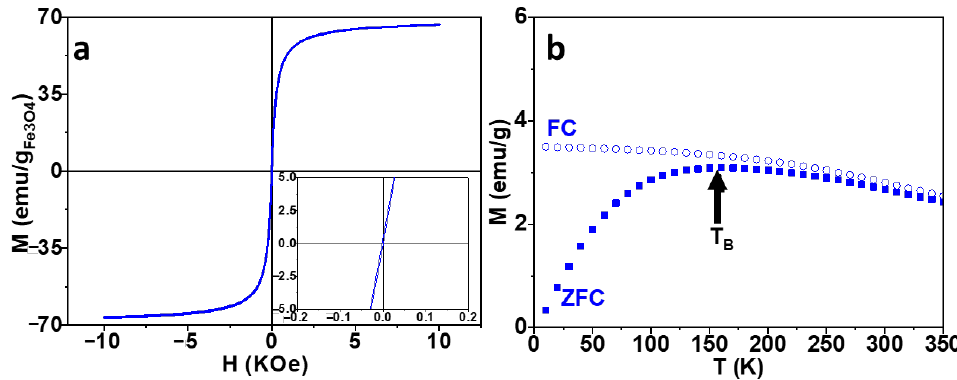
Figure 7. ( a ) Magnetic hysteresis loops measured at room temperature by VSM; ( b ) ZFC and FC magnetization curves measured under an applied field of 100 Oe for MSNs@SPIONs@PDA.